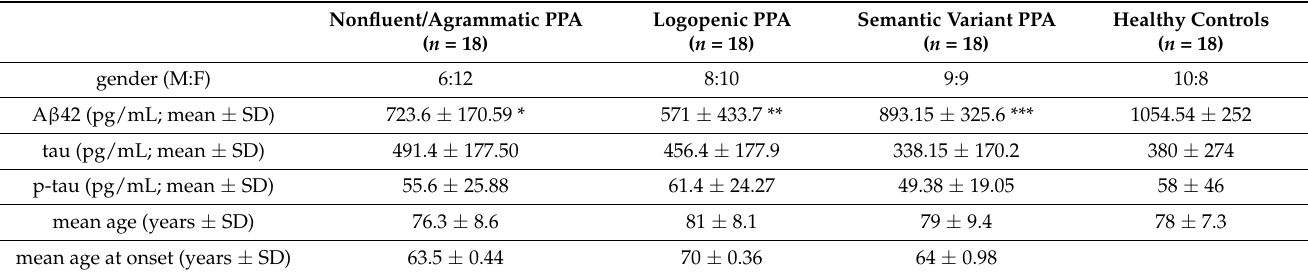
Table 1. Characteristics of PPA patients and